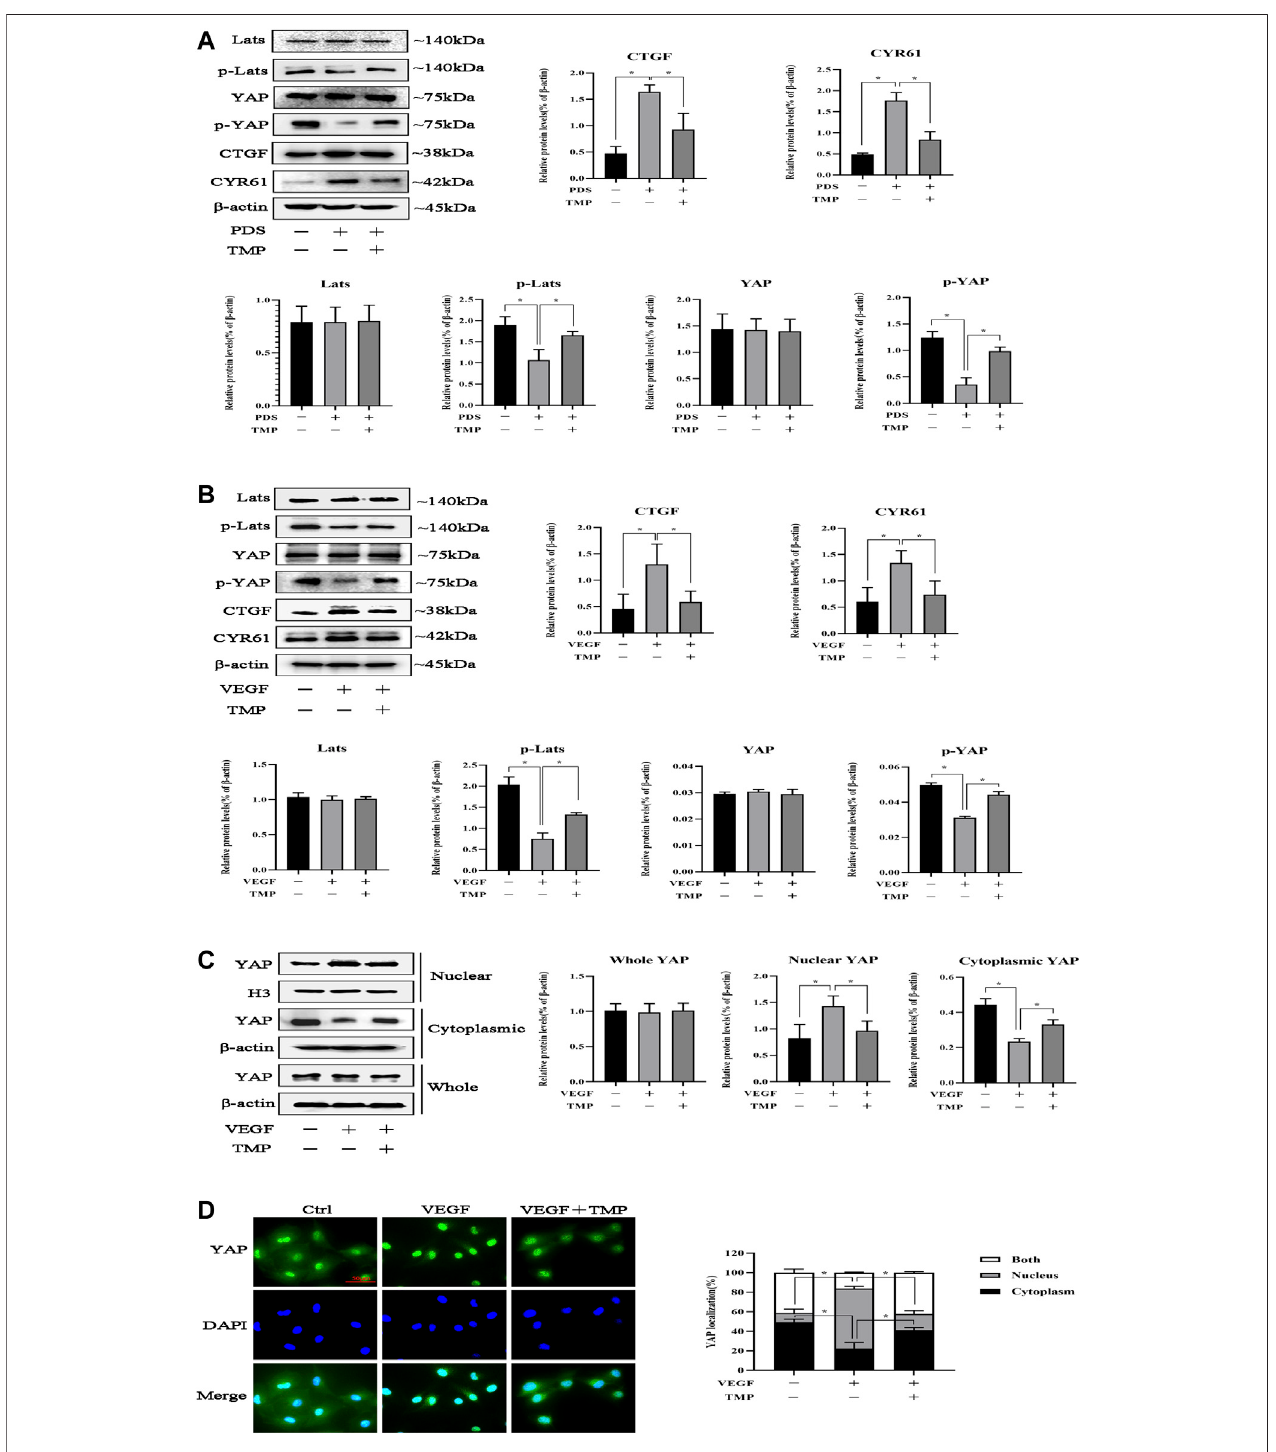
FIGURE 4 | Effect of TMP on YAP nuclear translocation. (A) Mice were treated by PDS with or without 80 nM TMP. Peritoneal tissues were homogenized using RIPA buffer for western blotting assay. Protein expressions of Lats, p-Lats, YAP, p-YAP, CYR61, and CTGF were detected. (B – D) HPVECs were exposed to 50 ng/ml VEGF with or without 40 μ M TMP. (B) Western blotting assays were used to detect Lats, p-Lats, YAP, p-YAP, CYR61, and CTGF of HPVECs. (C) HPVECs were lysed using the nuclear and cytoplasmic extraction reagents to obtain nuclear and cytoplasmic proteins. Western blotting assays were used to detect nuclear and cytoplasmic YAP expression. Histone H3 and β -actin were used as the loading controls for the nucleus and cytosol, respectively. (D) Immuno fl uorescence assays were performed to observe the subcellular translocation of YAP. YAP expressions in the cytoplasm and nucleus were visualized based on the green fl uorescent signal. The images were obtained by fl uorescence microscopy (scale bar (cid:2) 50 μ m). Data represent mean ± SEM of at least 3 independent experiments (* p < 0.05).